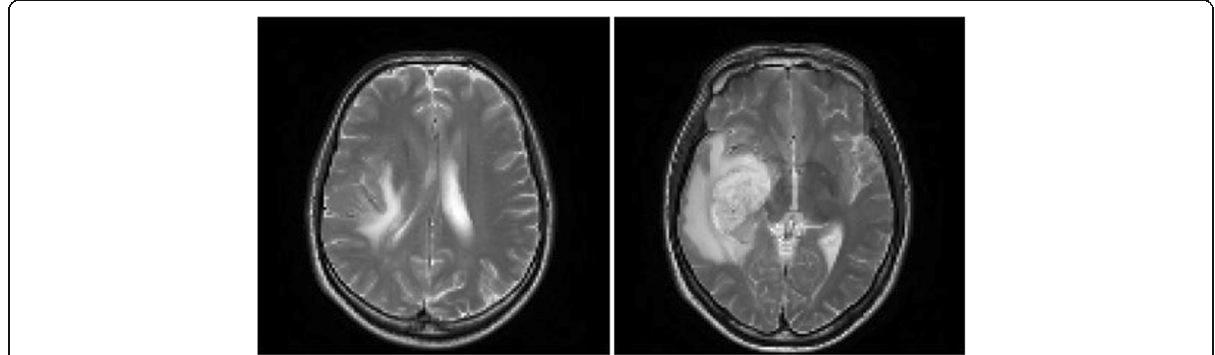
Fig. 1 Example slices from the entire brain set used in the stack viewing task, Experiment